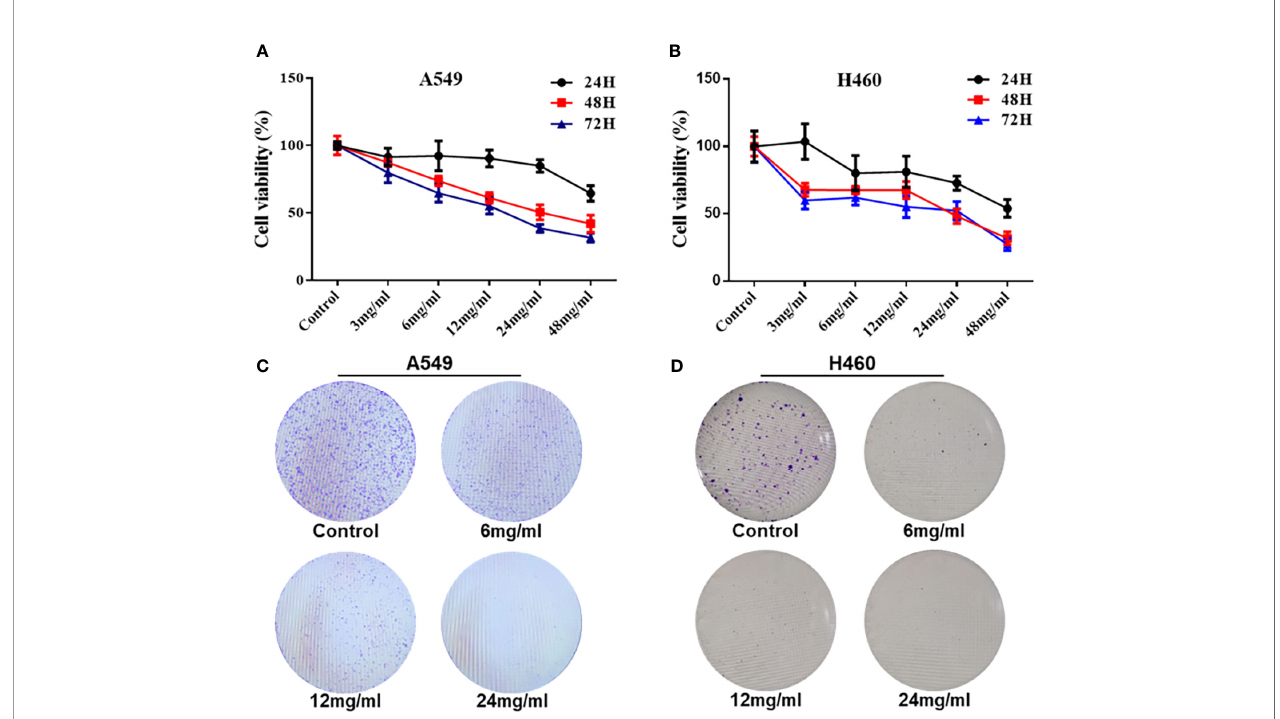
FIGURE 7 | HMMCR inhibits the proliferation of NSCLC cells. The viabilities of (A) A549 and (B) H460 cells after HMMCR treatment at the doses of 0 – 48 mg/ml for 0 – 72 h were measured by CCK-8. The self-renew ability of (C) A549 and (D) H460 cells after HMMCR treatment at the doses of 0 – 24 mg/ml for 48 h were measured by colony formation